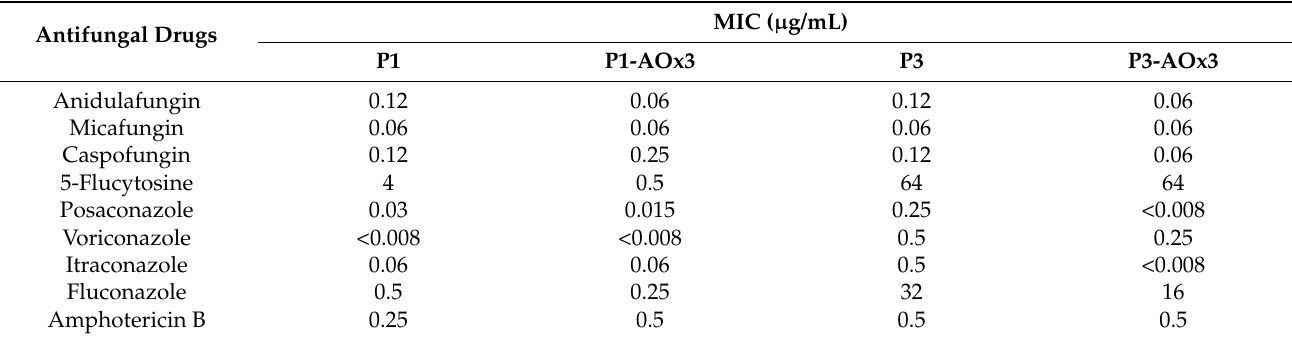
Figure 7. Milbemycin oxim 3 (AOx3) inhibits rhodamine 6G efflux. Efflux activities were performed as described in Material and Methods. Means of duplicates are reported. Glucose was added 300 s after start of measurements (arrow). Milbemycin AOx3 (5 µ g/mL) was added to indicated samples at start of experiment. Table 4. Effect of milbemycin AOx3 (5 µ g/mL) on antifungal